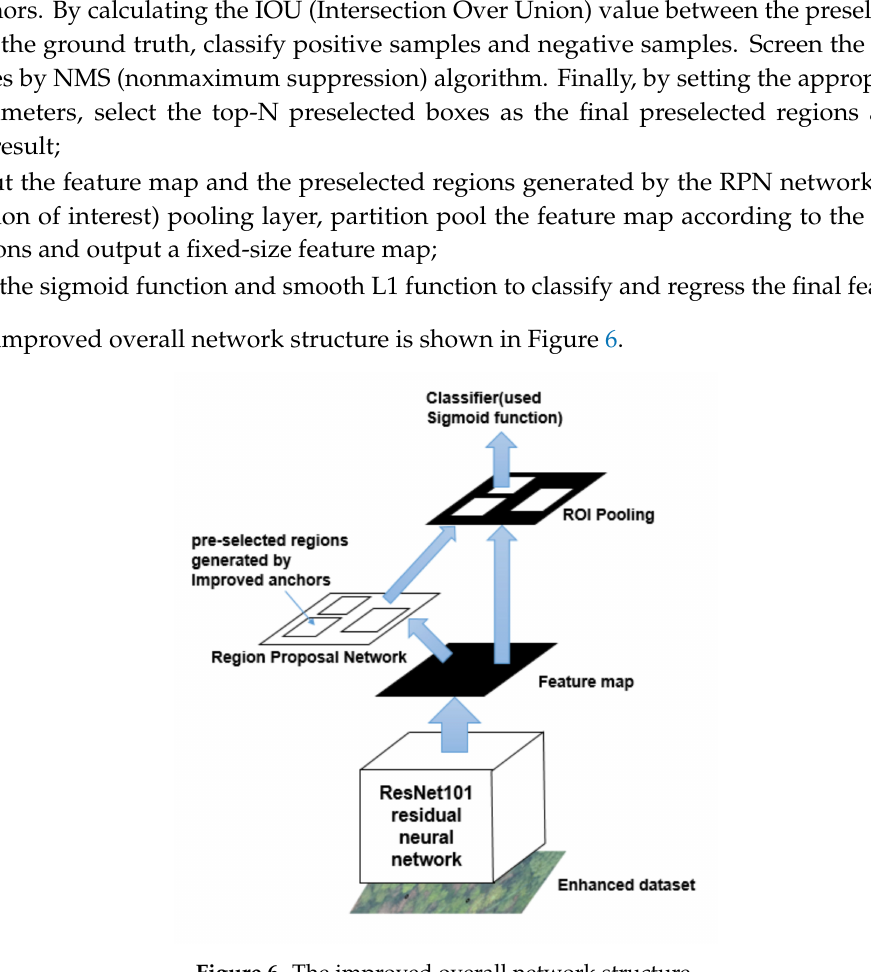
Figure 6. The improved overall network